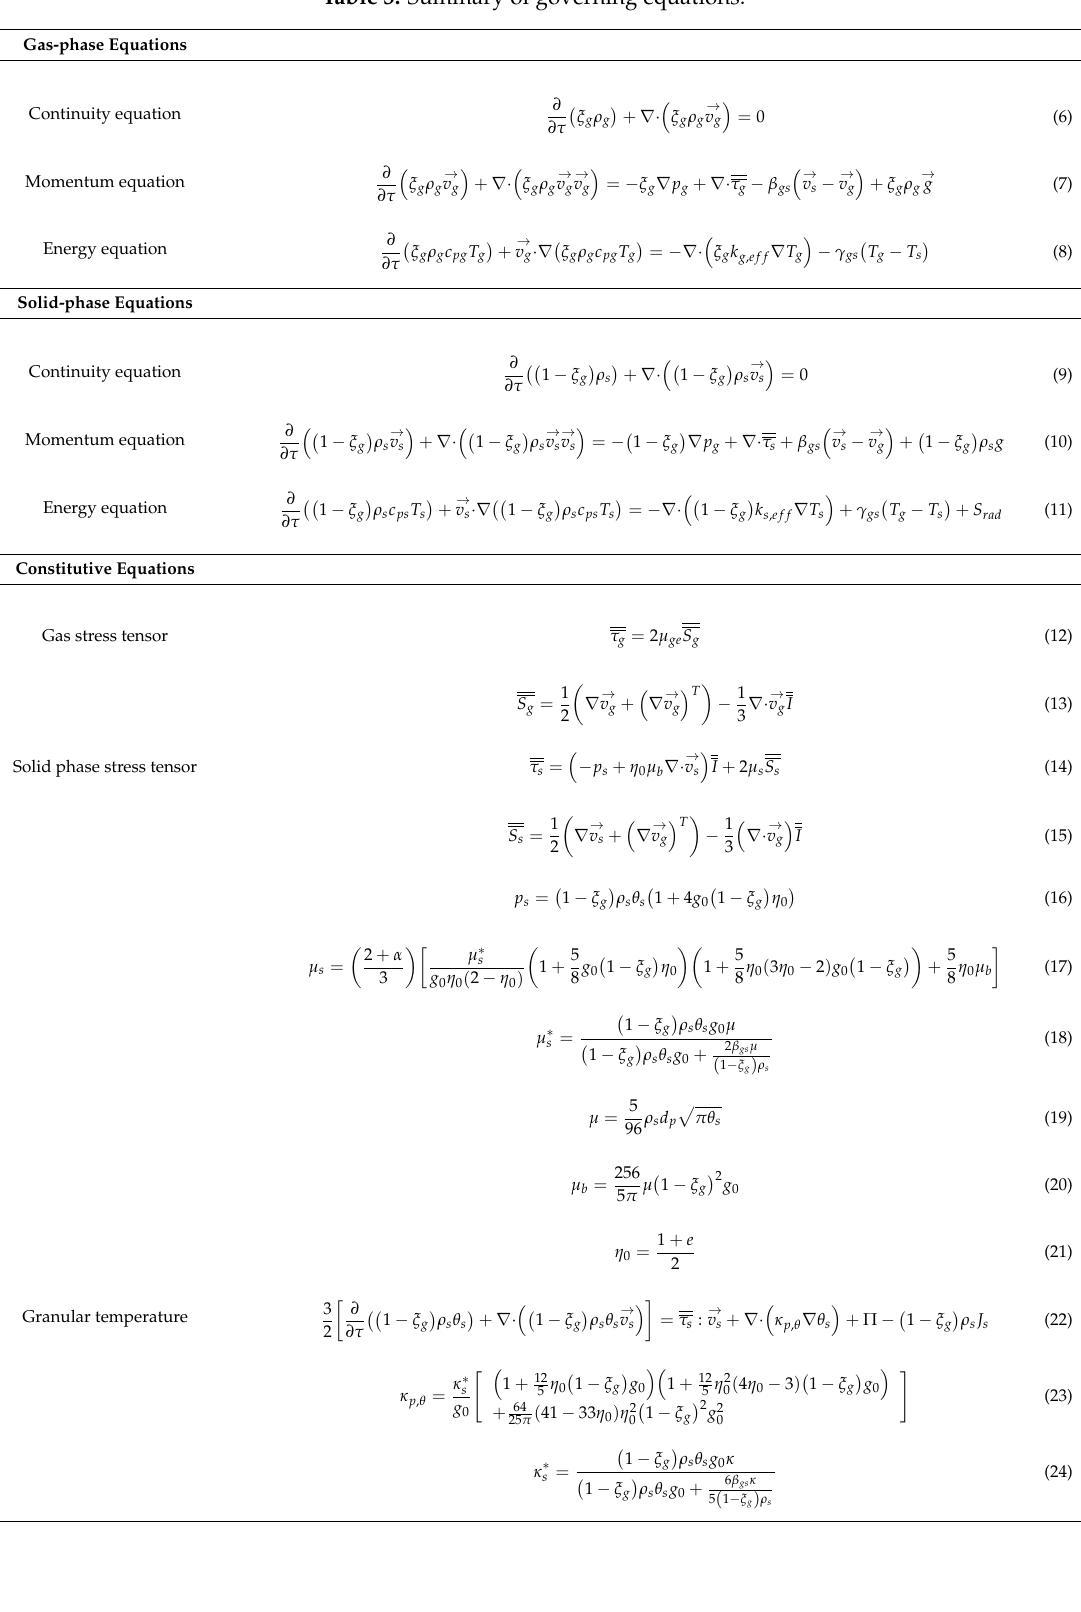
Table 3. Summary of governing